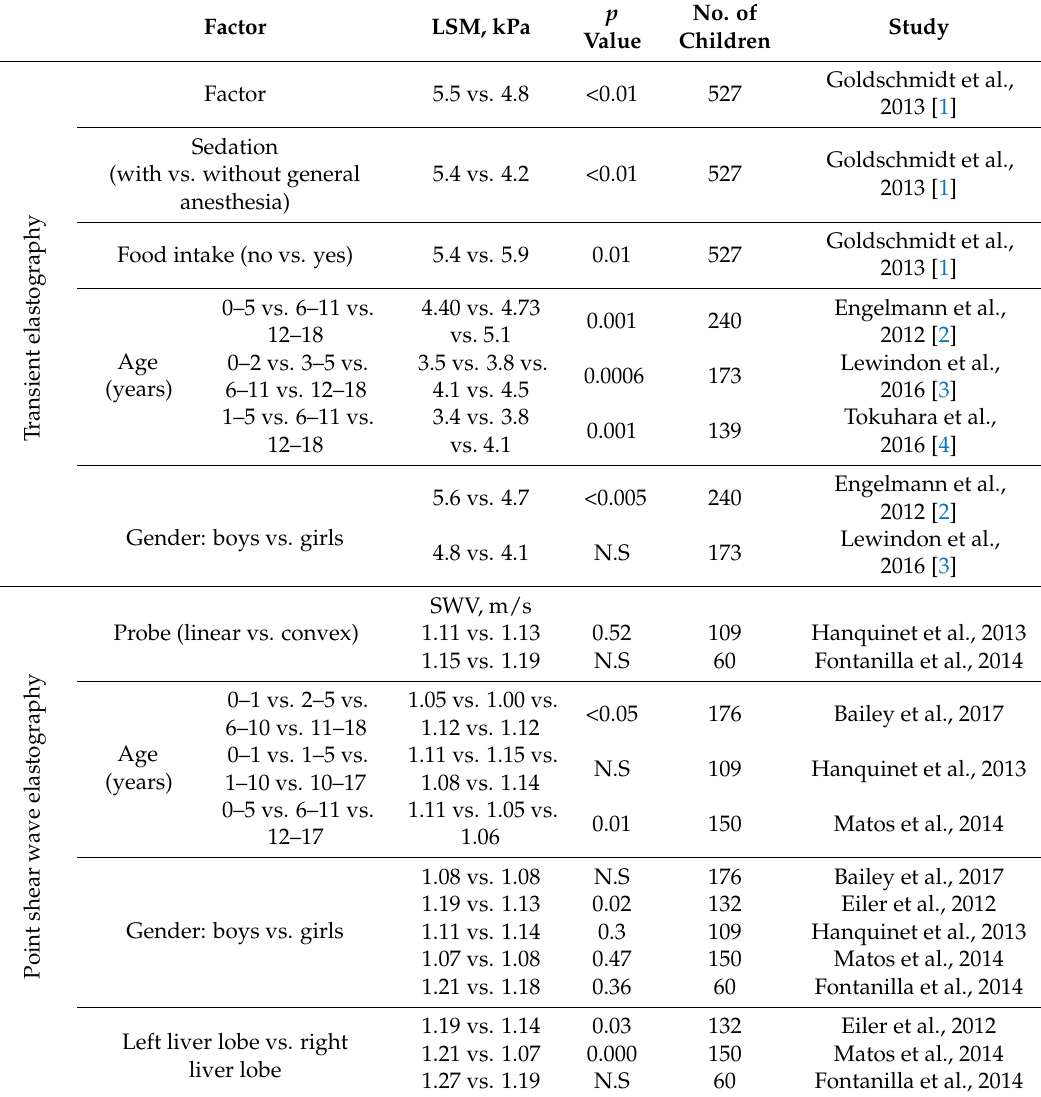
Table 1. Factors that may affect measurement of liver stiffness with shear wave elastography in healthy children. Factor LSM, kPa